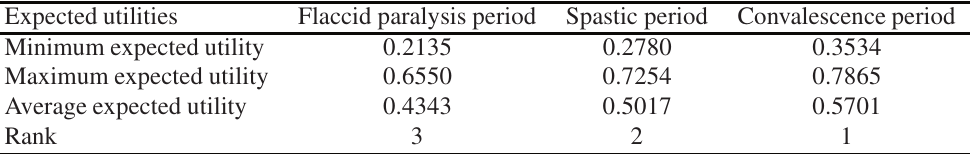
Table 5. The expected utilities of three periods and their ranking